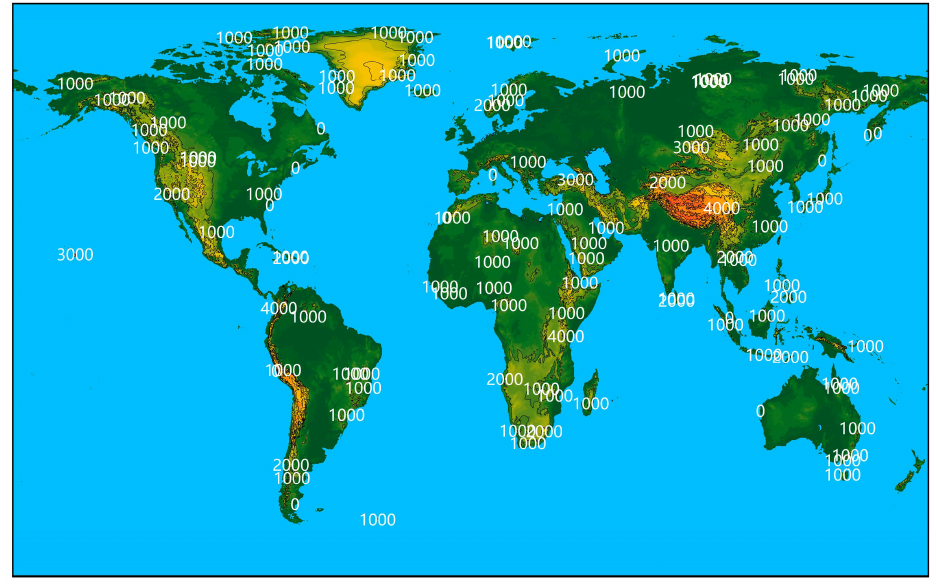
Figure 4. Distribution of global elevation. In the figure, the black boundary is the contour line of the region, and the white text is the elevation mark of the contour